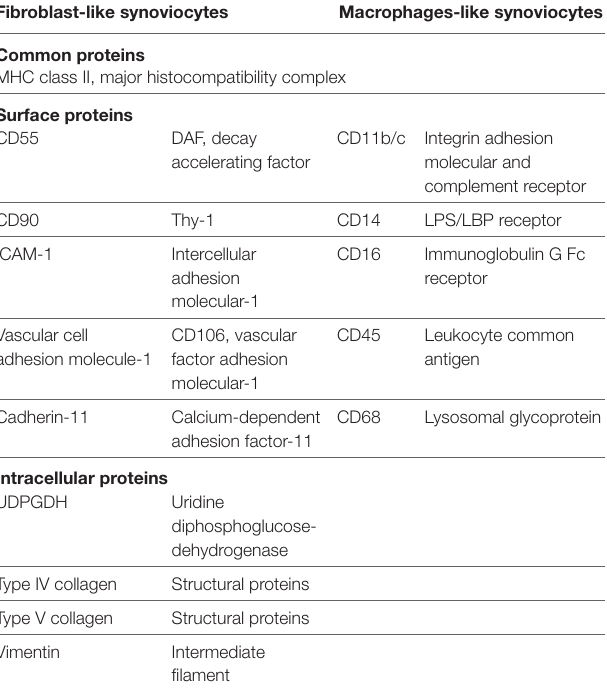
TABLe 1 | The specific markers for fibroblast-like synoviocytes and macrophage- like synoviocytes in mice. Fibroblast-like synoviocytes Macrophages-like synoviocytes Common proteins MHC class II, major histocompatibility complex Surface proteins CD55 DAF, decay CD11b/c Integrin adhesion accelerating factor molecular and complement receptor CD90 Thy-1 CD14 LPS/LBP receptor ICAM-1 Intercellular CD16 Immunoglobulin G Fc adhesion receptor molecular-1 Vascular cell CD106, vascular CD45 Leukocyte common adhesion molecule-1 factor adhesion antigen molecular-1